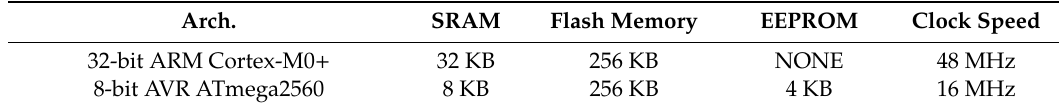
Table 4. Environment for performance